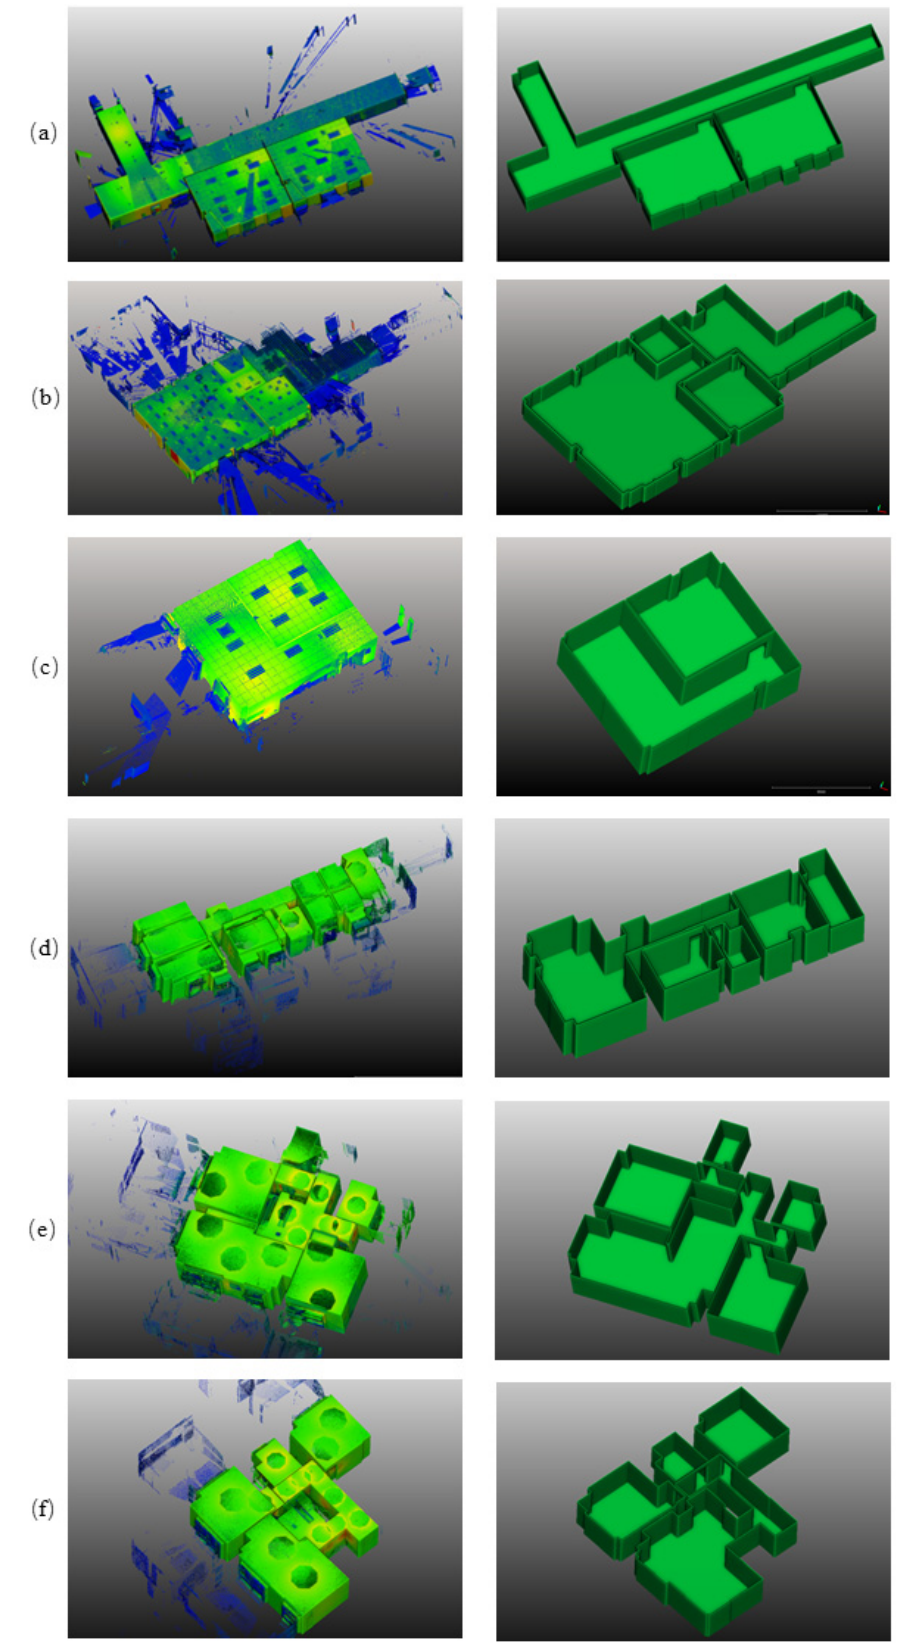
Figure 11. The point clouds and the corresponding watertight models (ceilings were removed for better visualisation) for the six sites: ( a ) Site 1, ( b ) Site 2, ( c ) Site 3, ( d ) Site 4, ( e ) Site 5, ( f ) Site 6.